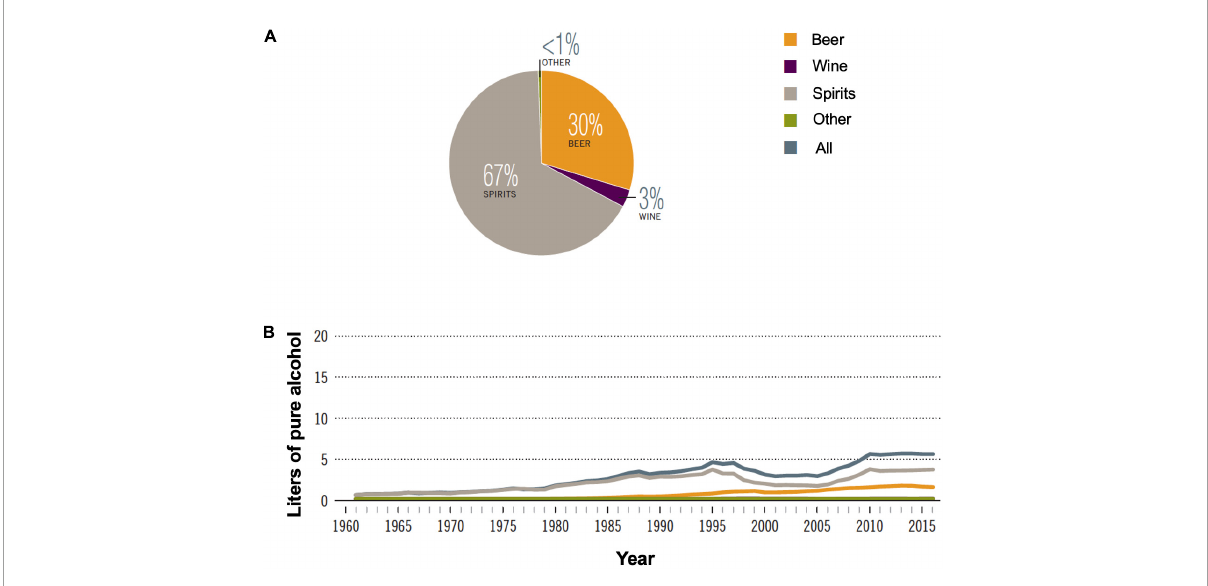
FIGURE3 Alcohol consumption in China. (A) Proportion of different alcoholic beverages consumed in 2016; (B) recorded alcohol consumption per capita in adults (age > 15 years), 1961–2016. Adapted with permission from ref (1) under Creative Commons Attribution-Non-Commercial-ShareAlike 3.0 IGO license. (CC BY-NC SA 3.0 IGO;